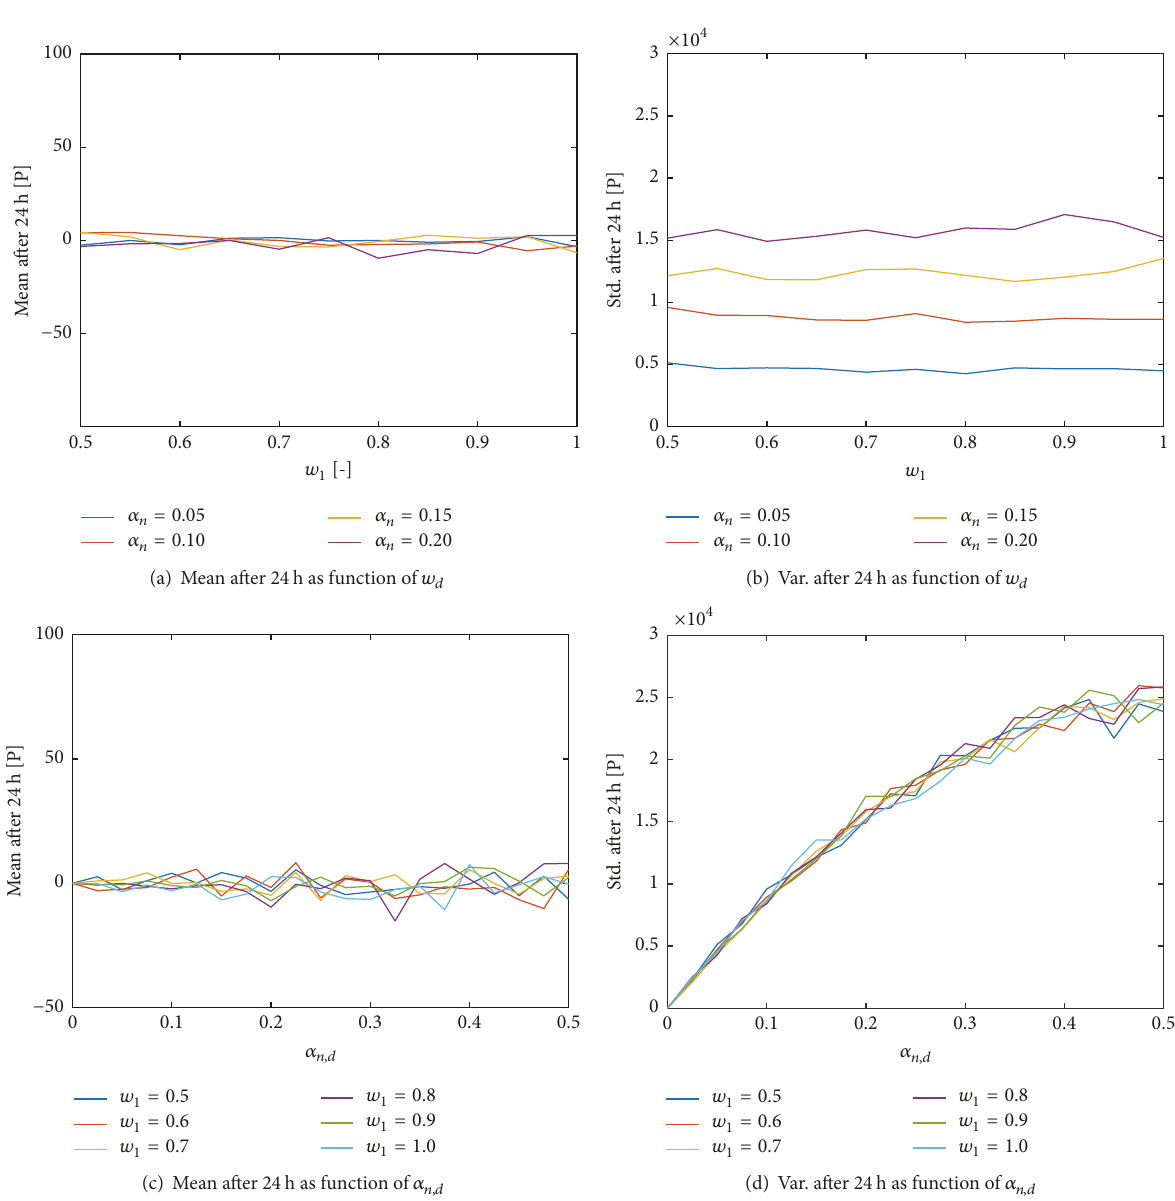
Figure 6: Case 1: visualisation of mean and standard deviation of the number of pedestrians in the region given a certain distribution over the entrances as a function of 𝑤 𝑑 and the detection error 𝛼 𝑛,𝑑